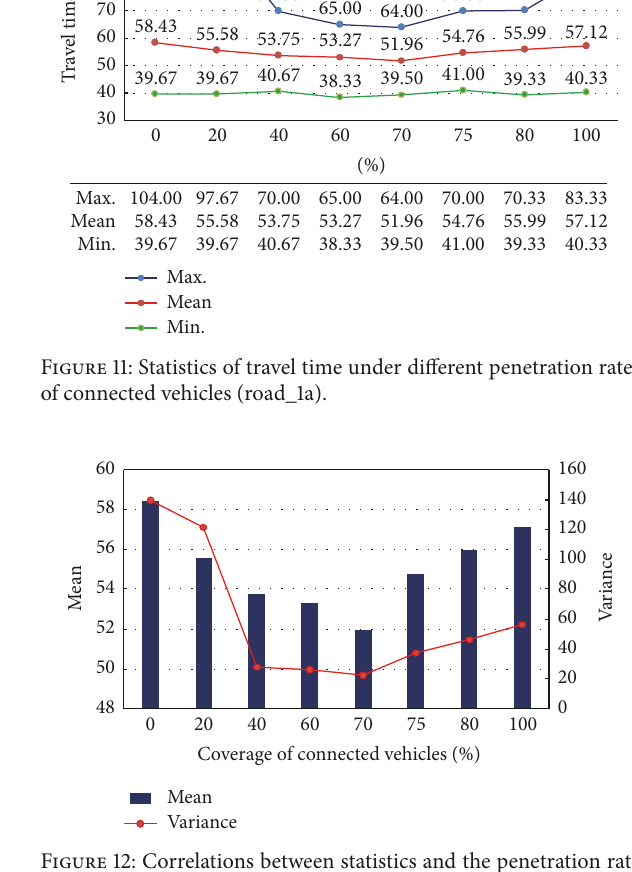
Figure 12: Correlations between statistics and the penetration rate of connected